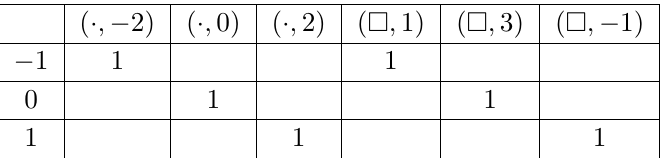
Table 1 . Paring of level-rank dual modules for H = SU(2) 1 (cid:2) U(1) 6 and H t = U(1) 3 . The entries not shown are